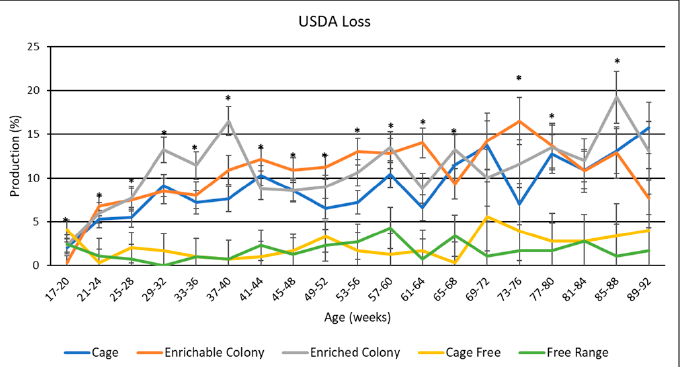
Figure 8. The effect of housing system on USDA grade loss production of brown egg layers by age. * Signifies a significant effect ( p < 0.05) of housing environment during that age range on USDA grade loss percentage.